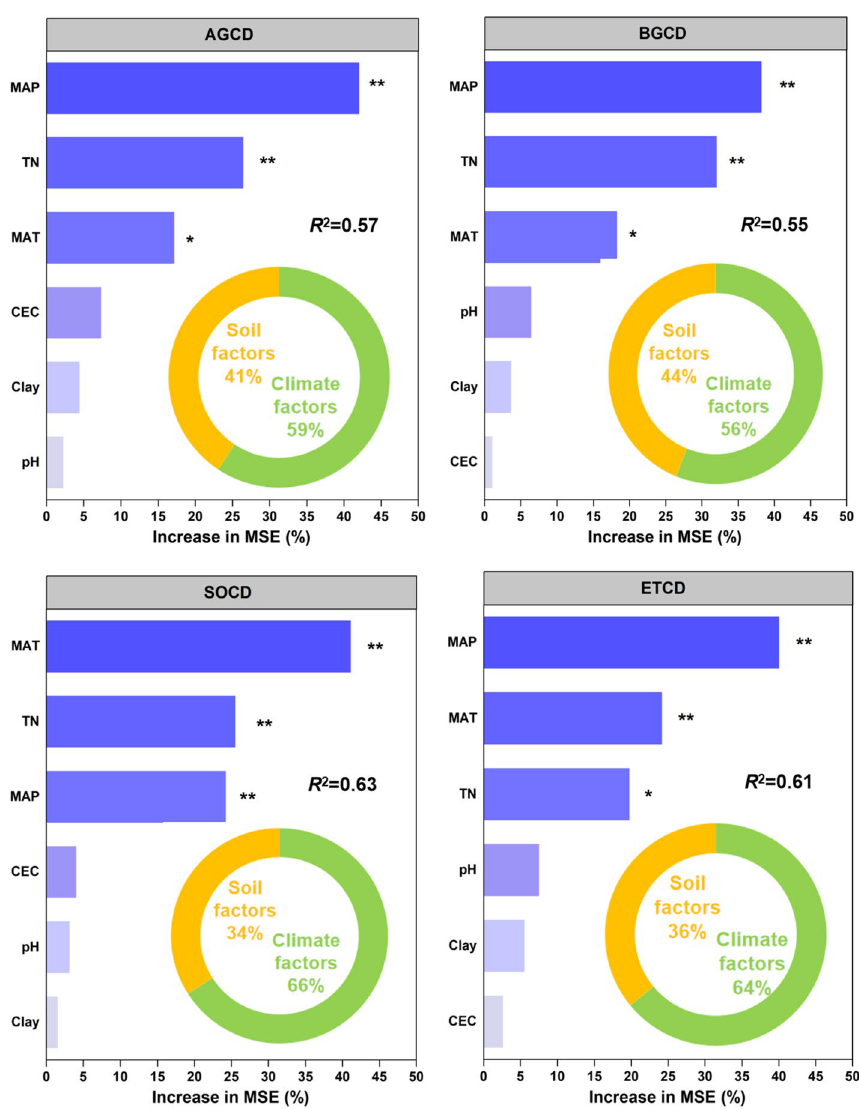
Fig. 7 The variation partitioning analysis of the relative explanatory rate of environmental factors to explain AGCD, BGCD, SOCD, ETCD. The circular rings mean the relative explanatory rate of soil and climate factors to AGCD, BGCD, SOCD, ETCD. The explained variability was calculated after 999 bootstraps. AGCD: above-ground carbon density; BGCD: above-ground carbon density; SOCD: soil organic carbon density; ETCD: ecosystem total carbon density; MAP: mean annual precipitation; MAT: mean annual temperature; pH: soil pH; TN: soil total nitrogen; CEC: soil cation